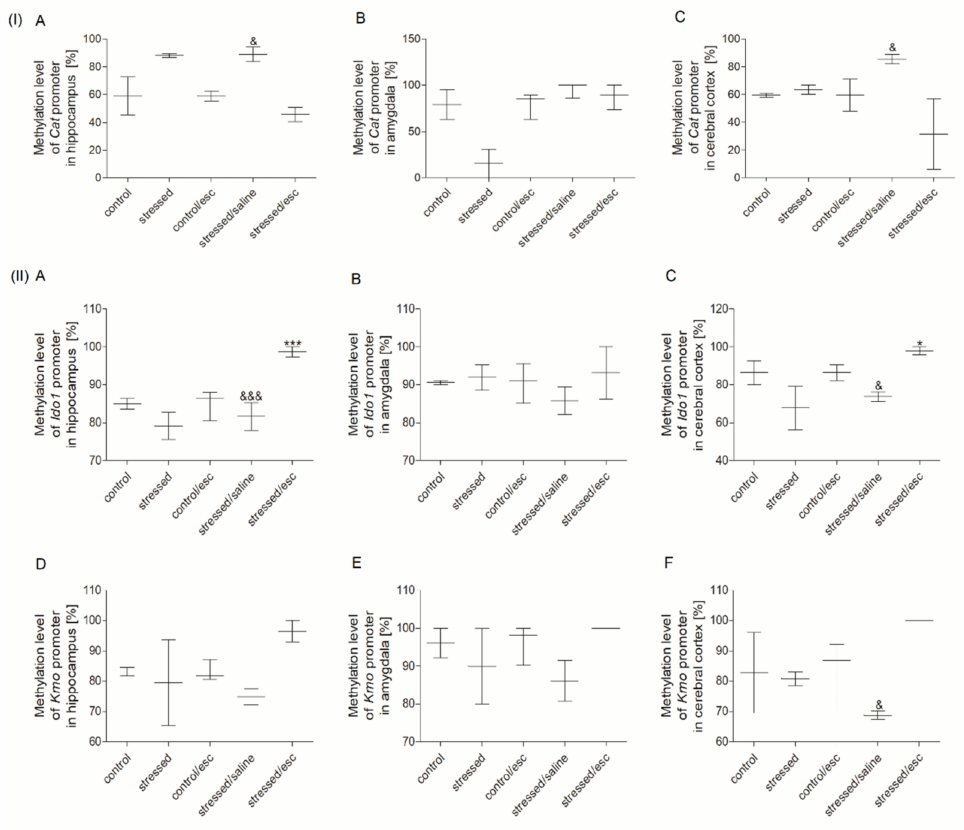
Figure 3. Methylation status of Cat promoter region ( I ) in the hippocampus ( A ), amygdala ( B ) and cerebral cortex ( C ) Ido1 and Kmo promoter regions ( II ) in the hippocampus ( A , D ), amygdala ( B , E ) and cerebral cortex ( C , F ) of animals exposed to CMS for two weeks (control, stressed) and in animals exposed to CMS for seven weeks and administered vehicle (1 mL/kg) or escitalopram (10 mg/kg) for five weeks (control/esc, stressed/saline, stressed/esc). Data represents median and maxiumum-minimum values. n = 6. * p < 0.05, *** p < 0.001 stressed/esc group relative to stressed group; & p < 0.05, &&& p < 0.001 stressed/esc group relative to stressed/saline